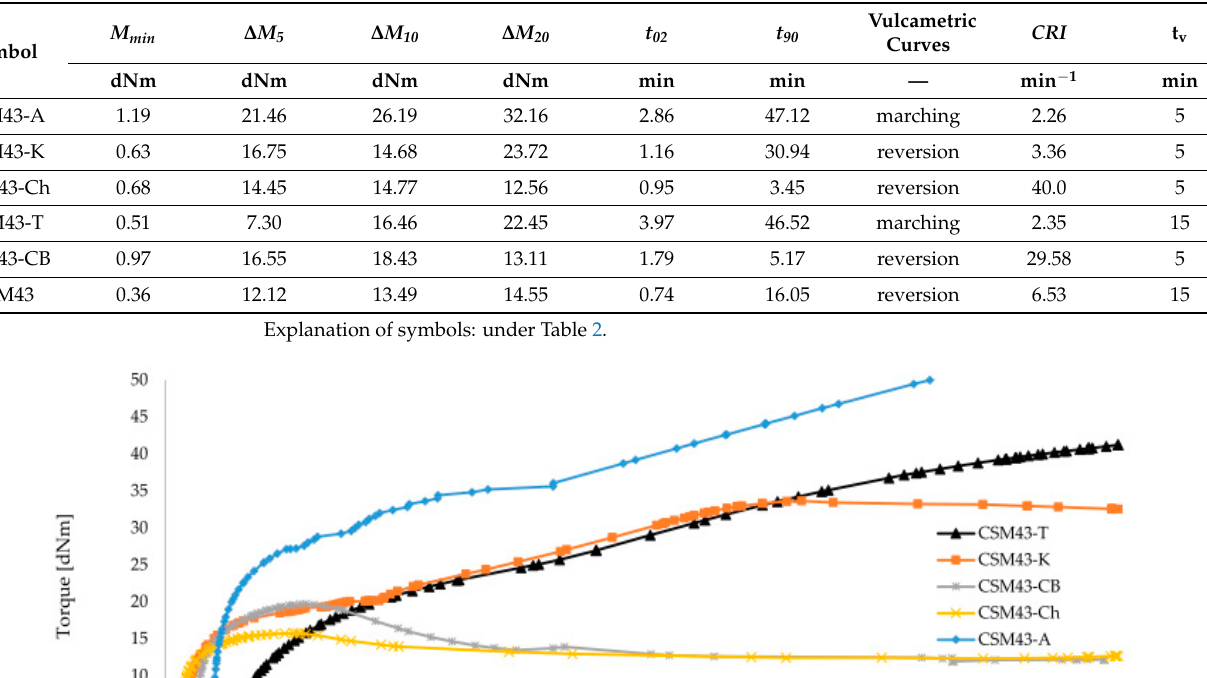
Table 6. Vulcametric parameters of the filled CSM43 compositions determined at the temperature of 160 ◦ C.